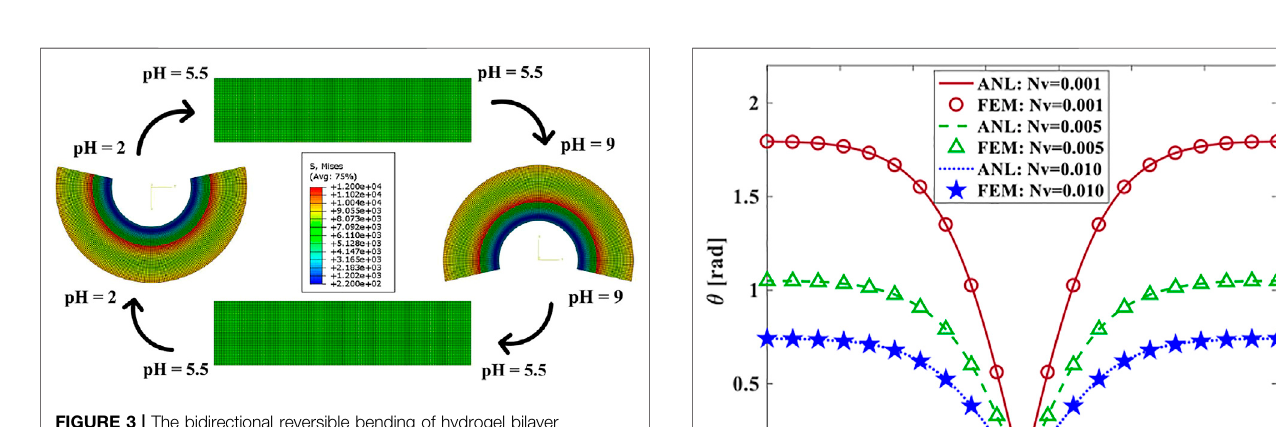
FIGURE 2 | The swelling ratio of a free (A) poly (HEMA-co-AA) and (B) poly (HEMA-co-DMAEMA) hydrogel subjecting to pH change of the surrounded solution.